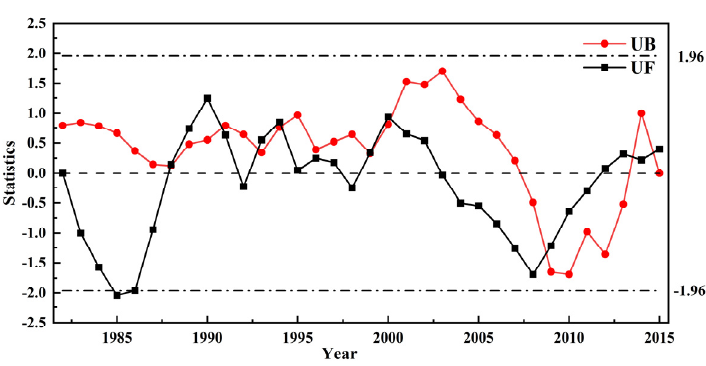
Figure 6. The results of the M-K test.